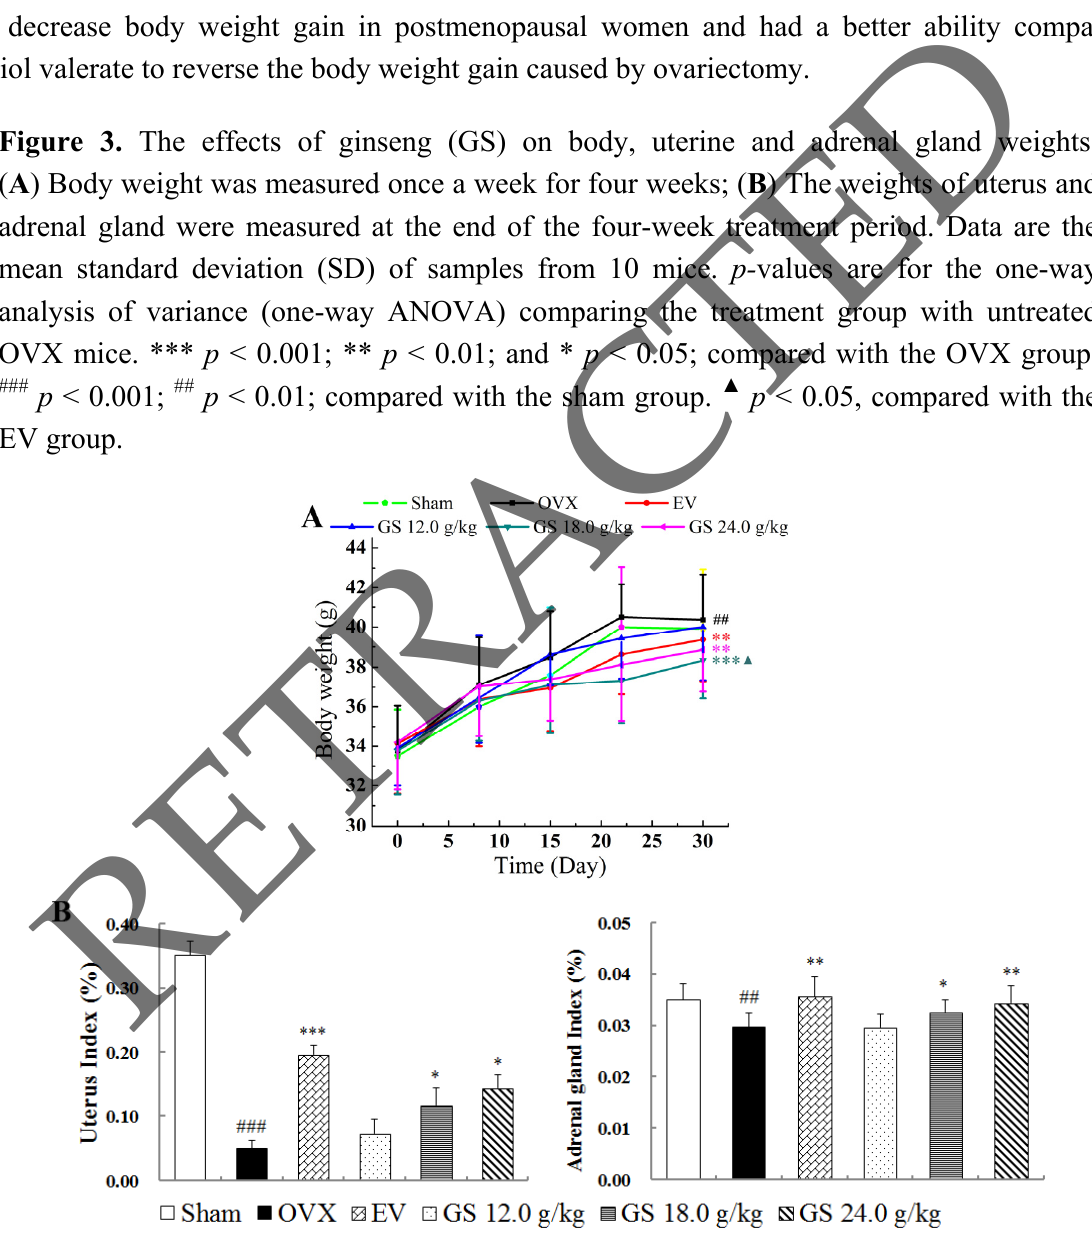
Figure 3. The effects of ginseng (GS) on body, uterine and adrenal gland weights. ( A ) Body weight was measured once a week for four weeks; ( B ) The weights of uterus and adrenal gland were measured at the end of the four-week treatment period. Data are the mean standard deviation (SD) of samples from 10 mice. p- values are for the one-way analysis of variance (one-way ANOVA) comparing the treatment group with untreated OVX mice. *** p < 0.001; ** p < 0.01; and * p < 0.05; compared with the OVX group. ### p < 0.001; ## p < 0.01; compared with the sham group. ▲ p < 0.05, compared with the EV